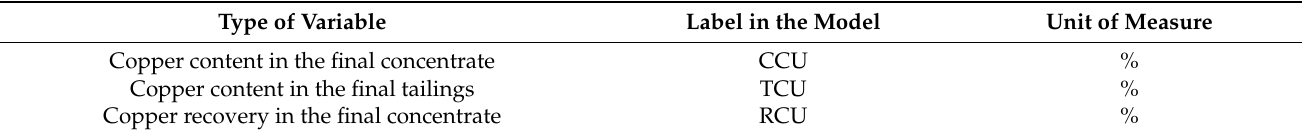
Table 3. Output (dependent)